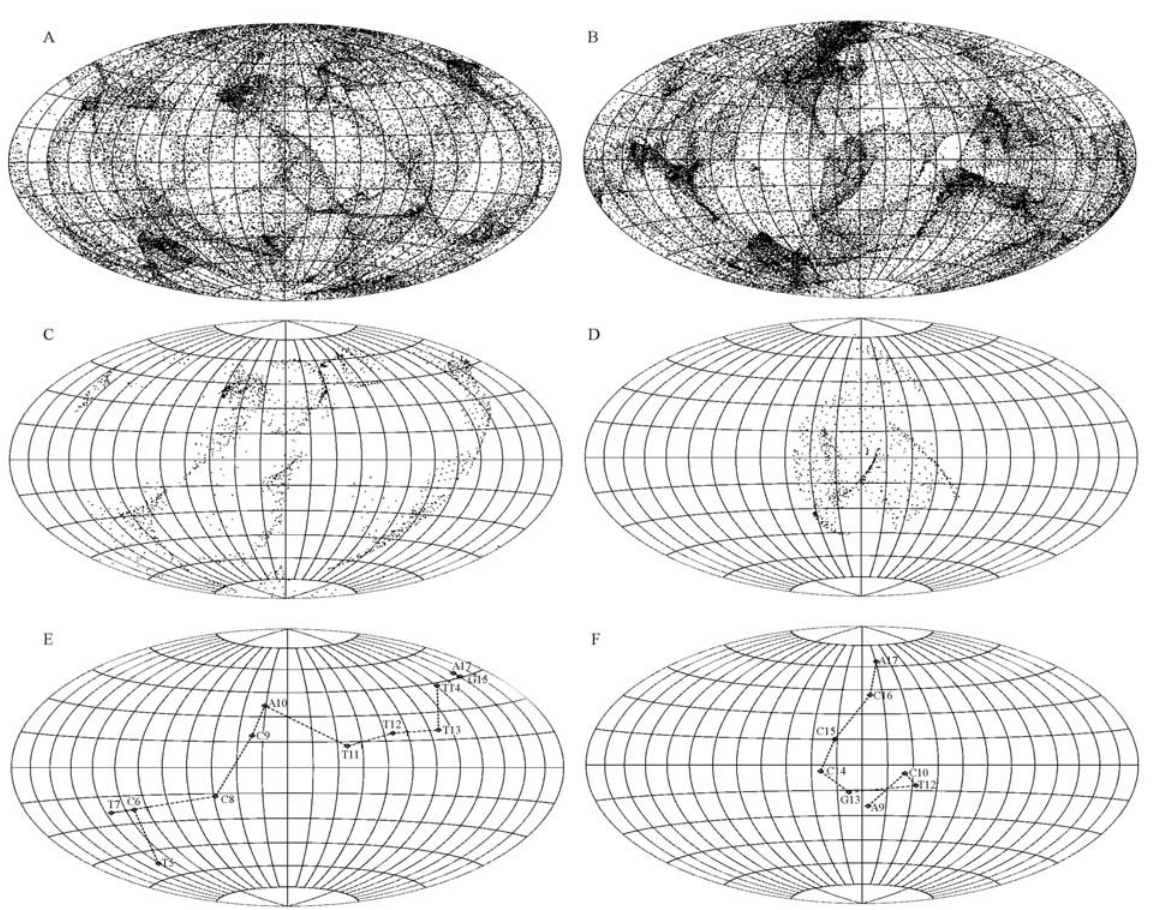
Figure 2 - Orientation distribution of the normal vectors of a protein surface shown on the earth map (A, C and E for the YY1 zinc finger-DNA complex; B, D and F for the P53-DNA complex). The normal vectors for the whole protein are shown in A and B, while the normal vectors involved in the DNA contact are shown in C and D. The normal vectors of the protein surface involved in DNA contact are averaged on a base-pair unit and are shown on the earthmap(E,F).Eachdiamond-shapedsymbolrepresentsabase-pair,andtheyarelinkedwithadashedlinetotracetheoverallorientationoftheaverage of the normal vectors. Also shown is the nucleotide sequence of the YY1 zinc finger protein-bound DNA (nucleotide sequence T5-C6-T7-C8-C9-A10- T11-T12-T13-T14-G15-A17, PDB ID: 1ubd) (E) and the P53-bound DNA (A9-C10-T12-G13-C14-C16-A17, PDB ID: 1tsr)